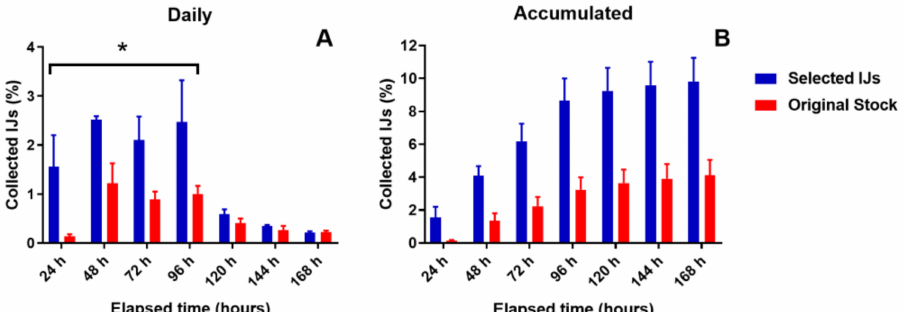
Figure 4. Percentage of S . australe IJs recovered over the time (hours) from a T-shaped modified olfac- tometer with an odor stimulus. Olfactometers were loaded with the treatments: (1) selected IJs (G6) (blue bars) and (2) IJs from the original stock (orange bars) and kept for 24 h. The Figure shows ( A ) the percentage of daily IJ recovery and ( B ) accumulated IJ recovery for both treatments. The asterisk shows significant differences in the percentage of IJs recovered between both treatments, according to the Student’s t -test ( p ≤ 0.05). * Bars with asterisk show statistically significant differences.